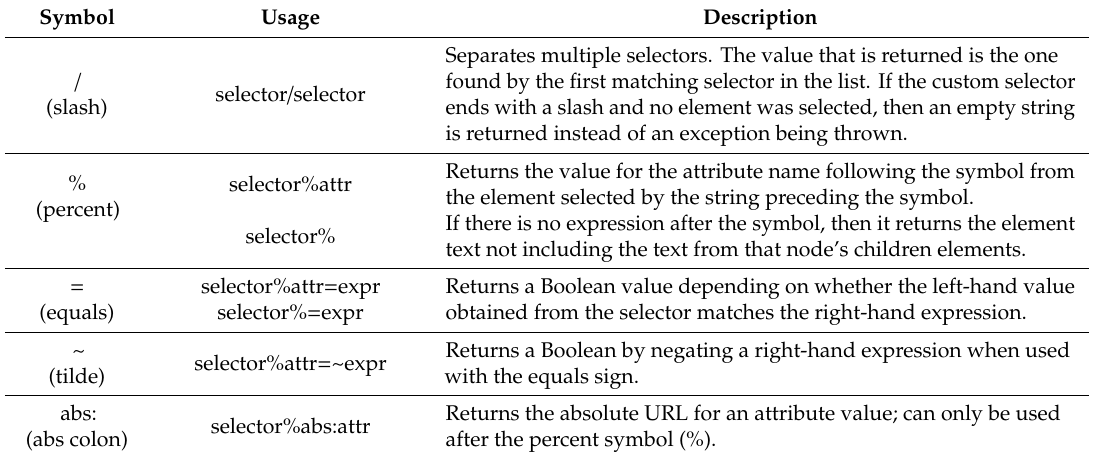
Table 1. The custom selector symbols that were added and are used by the product information extractor. Symbol Usage